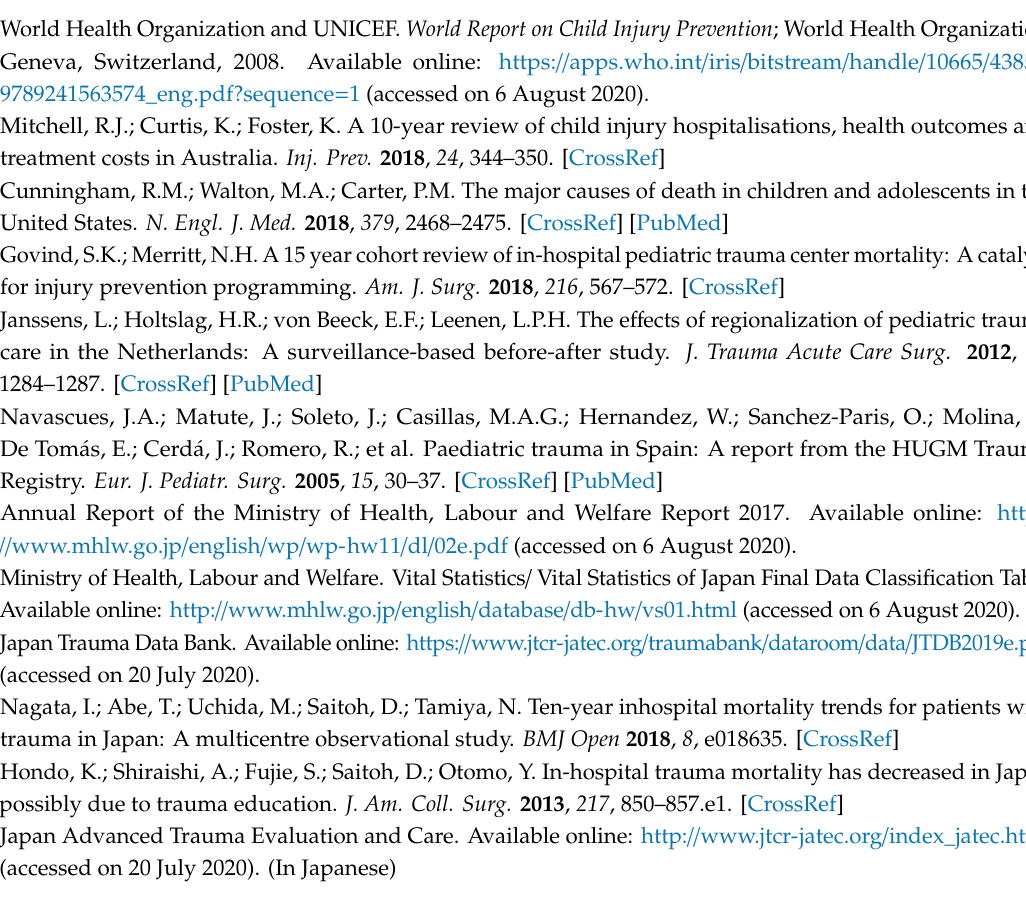
Supplementary Materials: Table S1. Missing data by year. The following are available online at http: // www. mdpi.com / 2077-0383 / 9 / 10 / 3273 /